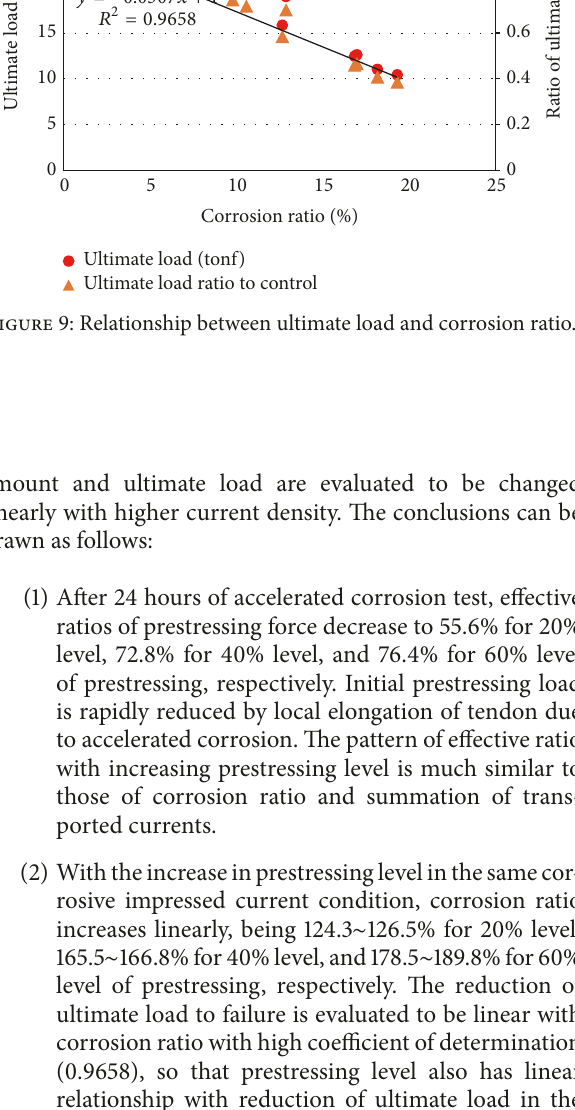
Figure 9: Relationship between ultimate load and corrosion